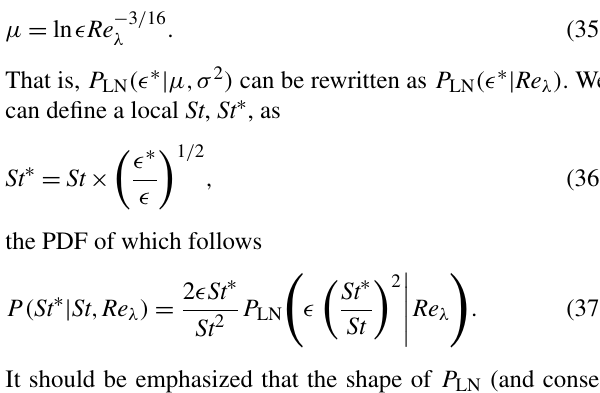
Figure 2. Radial distribution function (RDF) at the contact of monodisperse particles with St = 0 . 1, 0.4, and 0.6 against Re λ . The plotted open symbols are the reference DNS results. The lines are the results of Eqs. (40), (41), and (42), which were fitted to the sample values ( + ) with using the least-squares method. The error bars show ± one standard deviation obtained from more than three runs, with each run lasting for a time T 0 = L 0 /U 0 . Black solid cir- cle (right y axis) denotes the RDF at r/η = 0 . 25 for St = 0 . 6, nor- malized by the value at Re λ = 88 reported in Ireland et al.